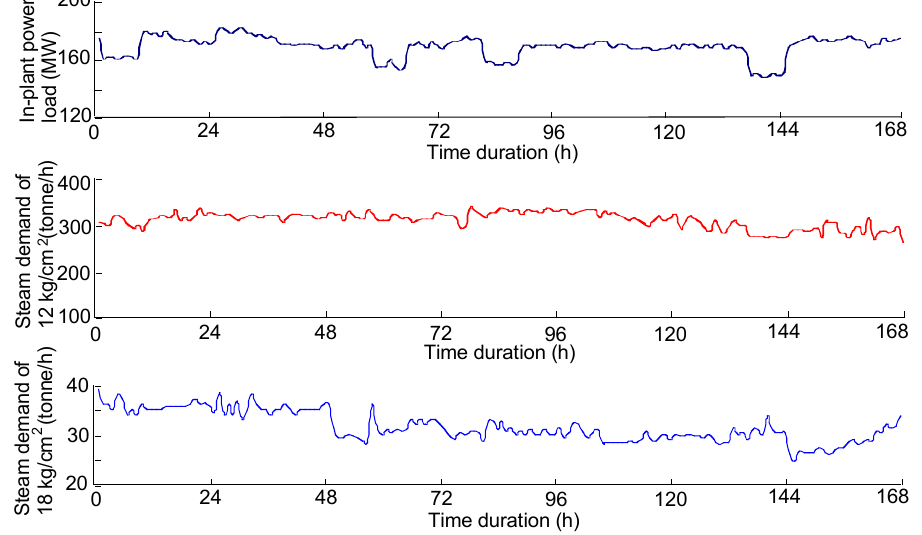
Figure 4. In-plant power load and steam demands during the non-summer months.